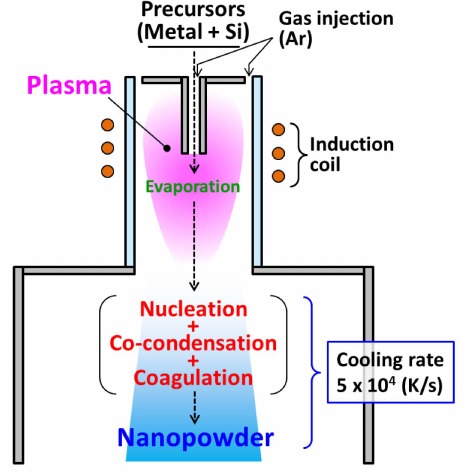
Figure 1. Metal–silicide nanopowder fabrication using an induction thermal